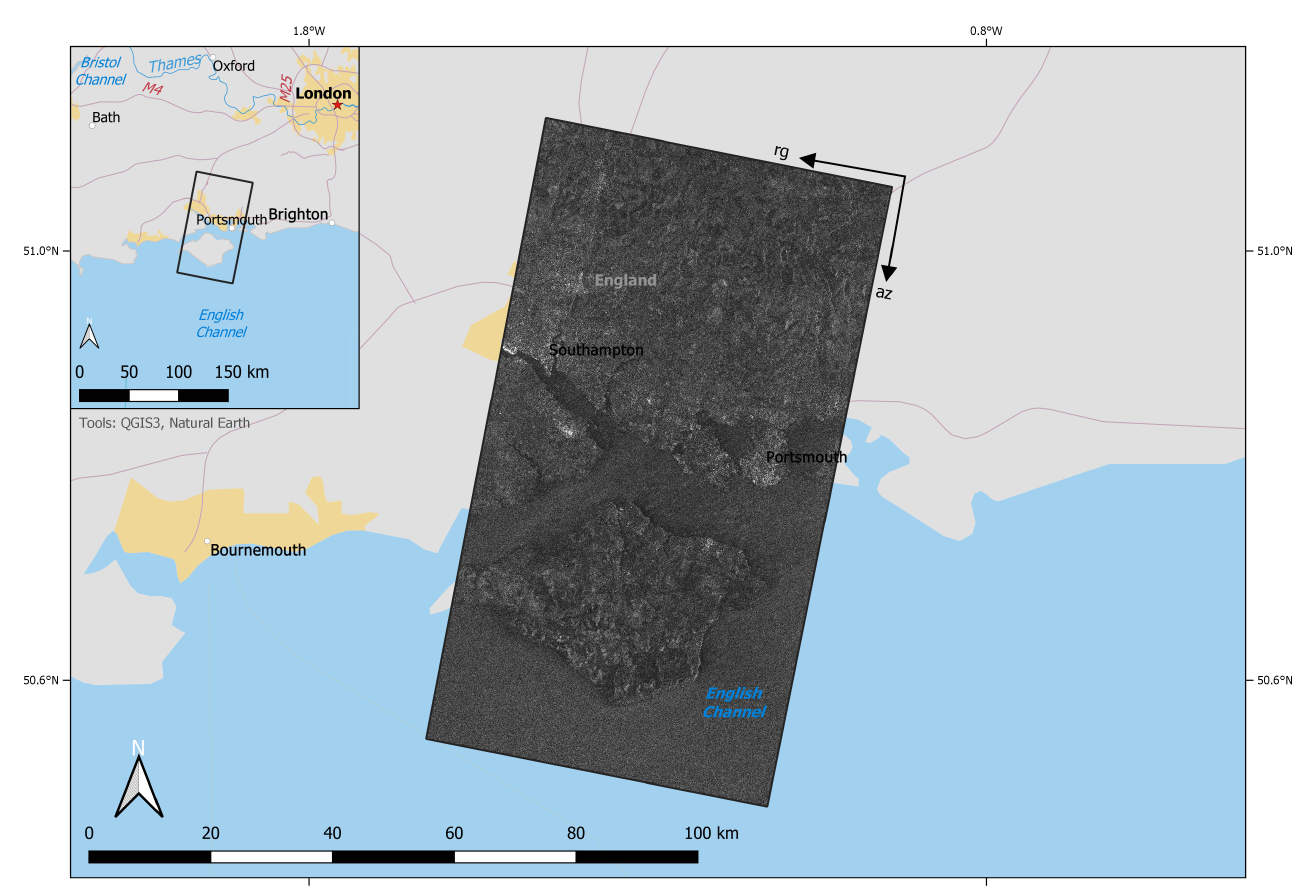
Figure 16. The Solent SAR product (VV polarisation).